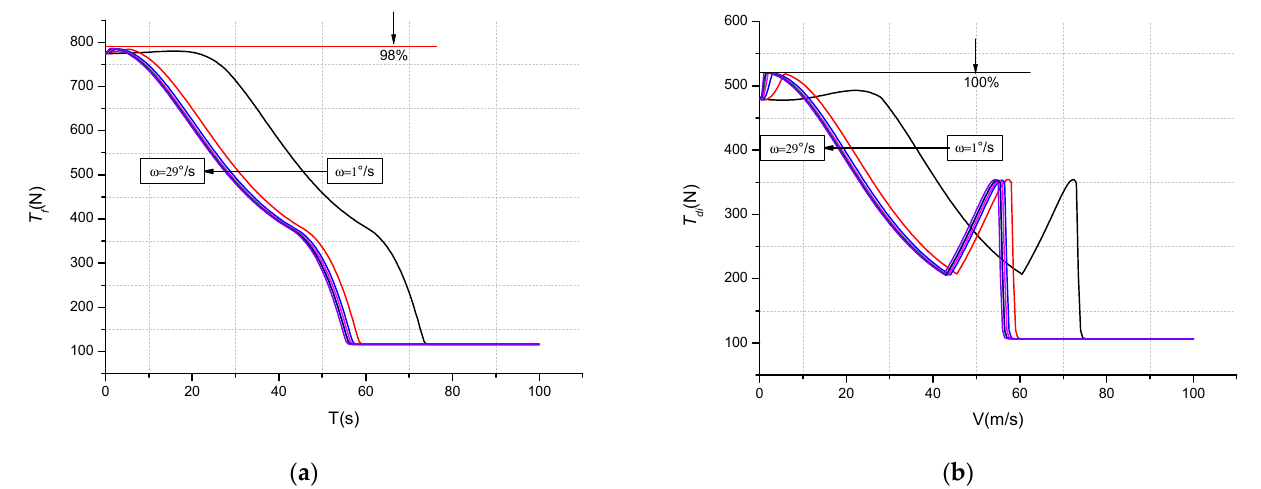
Figure 12. The influence of different deflection speeds on power. ( a ) Pull-force change curve of lift fan; ( b ) pull-force change curve of ducted lift-increasing system.